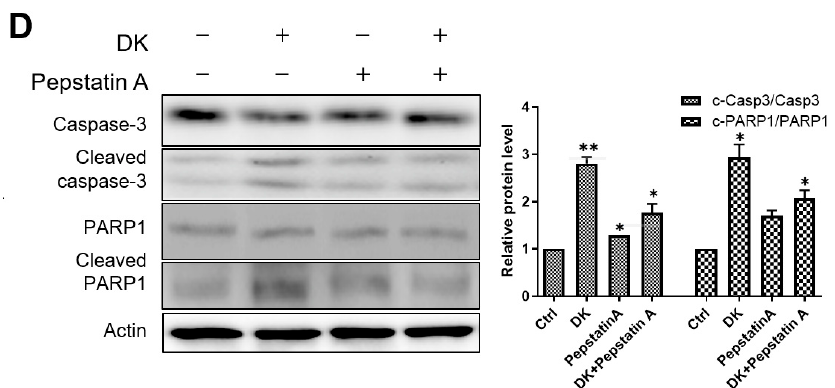
Figure 7. Dieckol (DK) decreases mitochondria membrane potential (MMP) and pepstatin A restored DK-induced MMP loss in cells. ( A ) A375 human melanoma cells were treated with various concentrations of DK for 48 h and the level of MMP were measured with JC-1 staining by flow cytometer analysis. Increased intensity of JC-1 green indicates decreased MMP. The intensity ratio of the green to red fluorescence was determined. Data is presented as the Mean ± standard deviation (SD). Representative images are shown. ( B ) Cells were treated with 3-methyladenine (3MA, 0.1 mM) or HCQ (15 μ M) in the presence or absence of 25 μ M DK for 48 h. The levels of MMP were measured with JC-1 staining as ( A ). ( C ) Cells were treated with E64D (50 μ M) or pepstatin A (50 μ M) in the presence or absence of 25 μ M DK for 48 h. MMP level was measured with JC-1 staining. ( D ) The expression levels of caspase-3, cleaved caspase-3, PARP1, and cleaved PARP1 were also analyzed by immunoblotting. Results are quantified and shown as mean ± standard deviation (SD) of triplicate independent experiments. *** p < 0.001, ** p < 0.01, * p < 0.05 compared to the control.